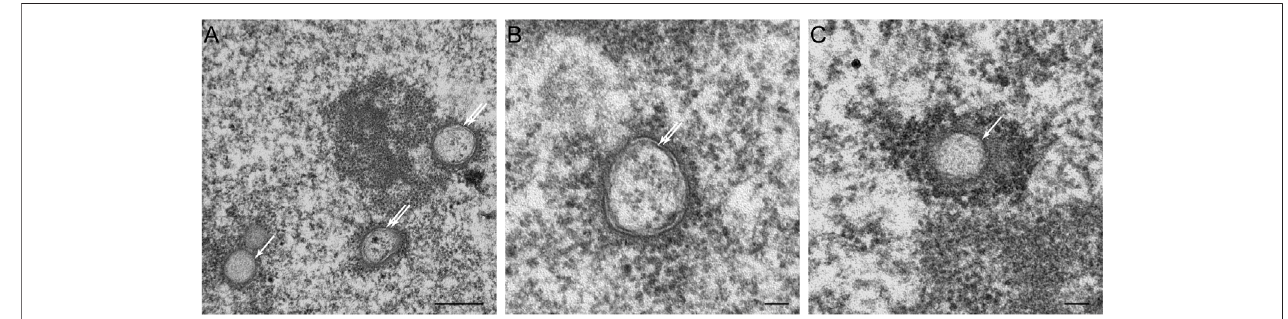
FIGURE 7 | The effects of lovastatin treatment on the nucleus of CHO-cells at the electron microscopy (EM)-level. (A) EM recording of two types of tubular invaginations in CHO cells treated with lovastatin. Type I invaginations are marked by a single arrow, type II by a double arrow. Scale bar indicates 0.5 μ m. (B) Detailed recordingoftypeIINRinCHOcellstreatedwithlovastatin.Scalebarindicates0.1 μ m. (C) DetailedrecordingofatypeINRinCHOcellstreatedwithlovastatin.Scalebar indicates 0.1 μ m. Ultrathin sections from fi broblasts of CHO cells were studied by electron microscopy (for sample preperations, see Figure 5 ) for nuclear membrane invaginations after 18 h of incubation with 40 μ M of lovastatin (see also Verstraeten et al., 2006).